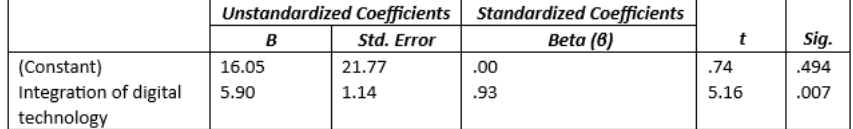
Figure 11. Linear regression: digitalization and labor productivity—Romania.